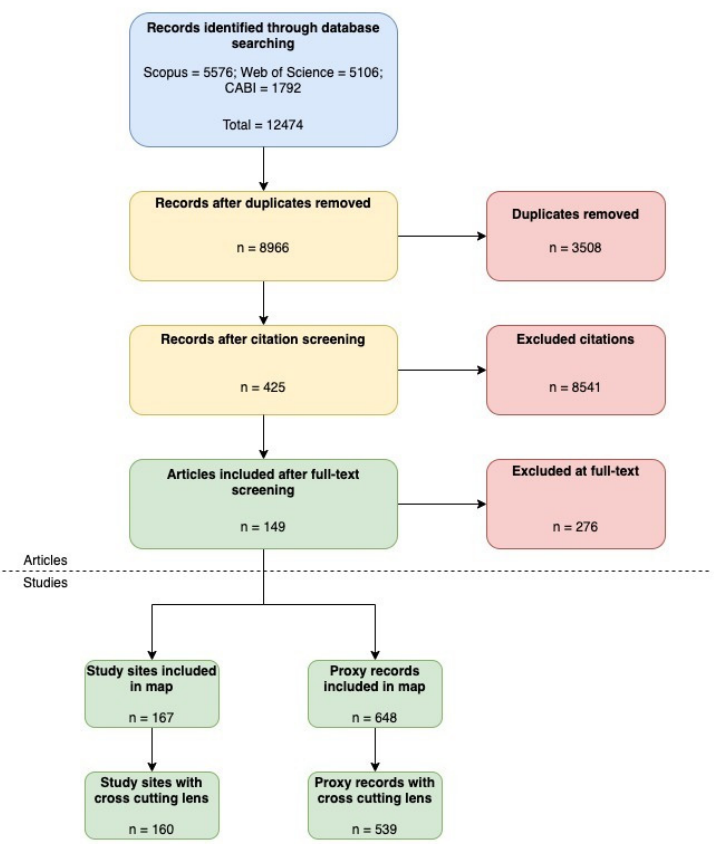
Figure 4. Reporting standards for Systematic Evidence Syntheses (ROSES) diagram detailing the steps taken in identifying literature, screening articles, and splitting individual studies from articles.